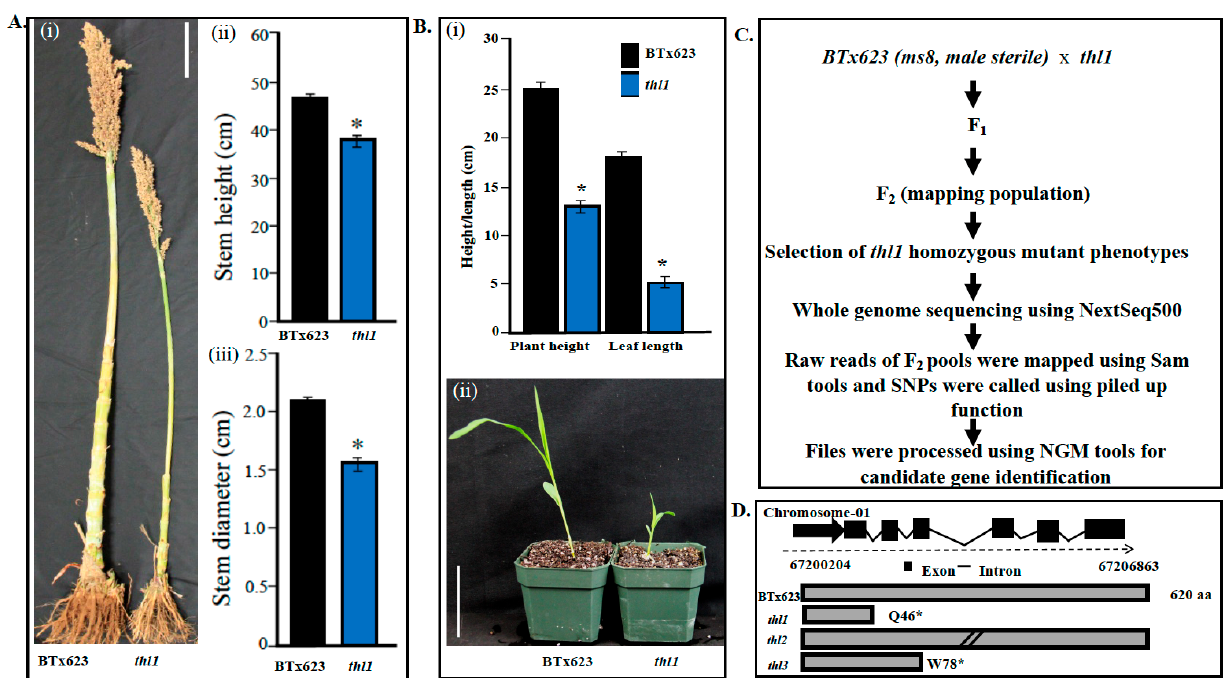
Figure 1. Phenotyping and mapping of sorghum thl1 mutant locus using MutMap approach. ( A ). (i) Comparison of BTx623 and thl1 mutants. (ii) Graph showing stem height of BTx623 and thl1 . Scale bar: 10 cm. (iii) Graph showing stem diameter of BTx623 and thl1 . ( B ). (i) Graph showing seedling height and leaf length of BTx623 and thl1 . (ii) Images of BTx623 and thl1 seedlings. Scale bar: 9 cm. ( C ). Flow chart showing generation of mapping population and thl1 mutant mapping using MutMap approach. ( D ). Gene structure of THL1 (exons and introns) and protein length of BTx623 and thl mutants. * Represents significant difference.